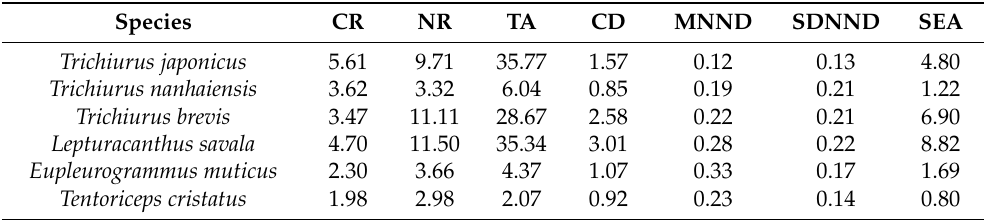
Table 3. Parameters of trophic structure of six hairtail species CR, range of δ 13 C; NR, range of δ 15 N; TA, total area of the convex hull; CD, mean distance to centroid; MNND, mean nearest neighbor distance; SDNND, standard deviation of nearest neighbor distance; SEA, standard ellipse area.